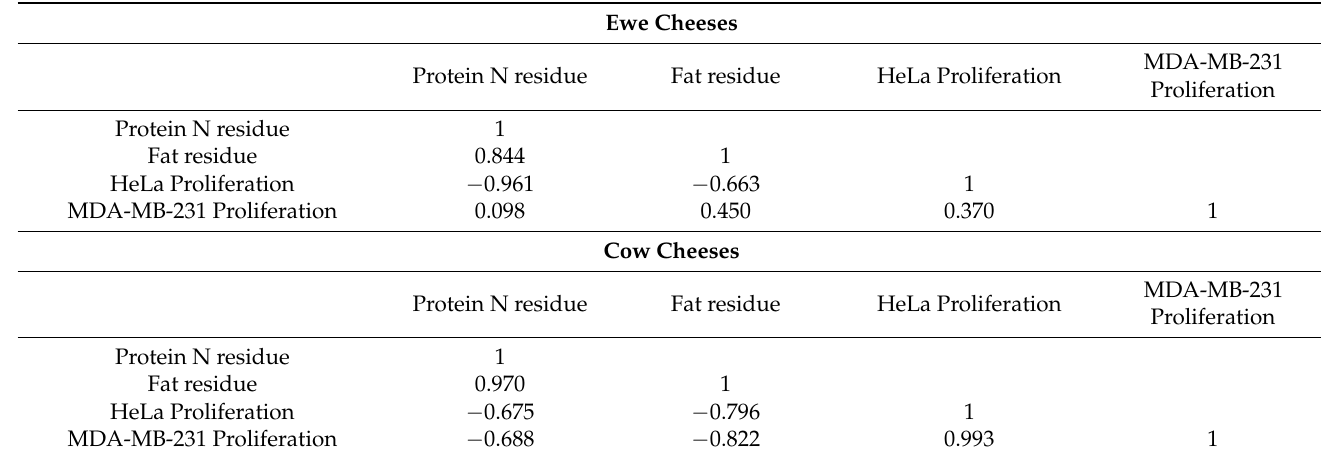
Table 3. Pearson’s correlation analysis of the crocin-rich extracts in ewe and cow cheeses. Ewe